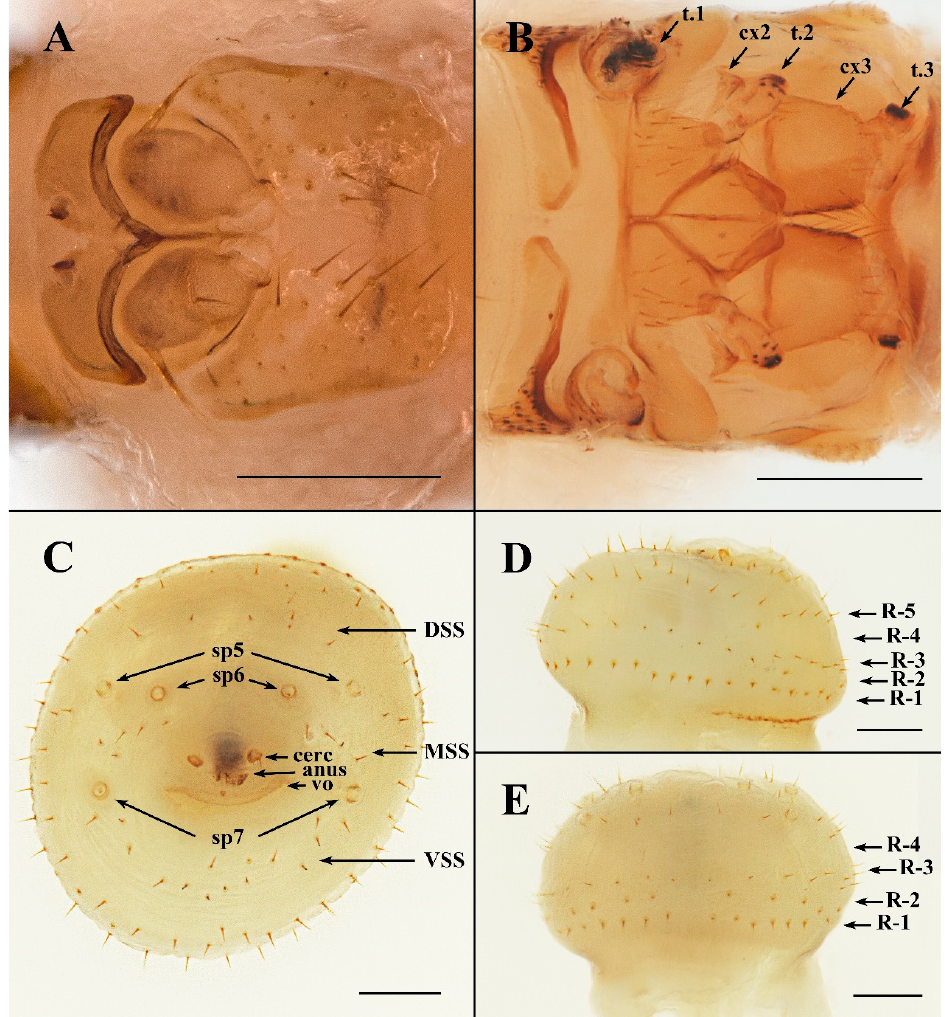
Figure 4. Ascodipteron guoliangi sp. nov., ex. Coelops. frithii , China (BFU-2437, neosome paratype). ( A ). Frons and lateral vertex. ( B ). Thorax, ventral view. ( C ). Terminalia, posterior view. ( D , E) . Ter- minalia, ventral view ( D ) and dorsal view ( E ), indicating five terminal annular rows of setae (R4 absent, R5 only in ventral view). Abbreviations: cerc—cercus; cx1–3—coxa 1–3; DSS—dorsal spirac- ular setae; MSS—medial spiracular setae; R1–5—abdominal setae arranged roughly into annular rows comprised of variable types of setae, R1 the proximal and R5 the distal row; sp5–sp7—spiracles 5–7; t.1–3—trochanter 1–3; vo—vaginal orifice; VSS—ventral spiracular setae. Scale bars: A , B = 100 μ m; C , D = 200 μ m.